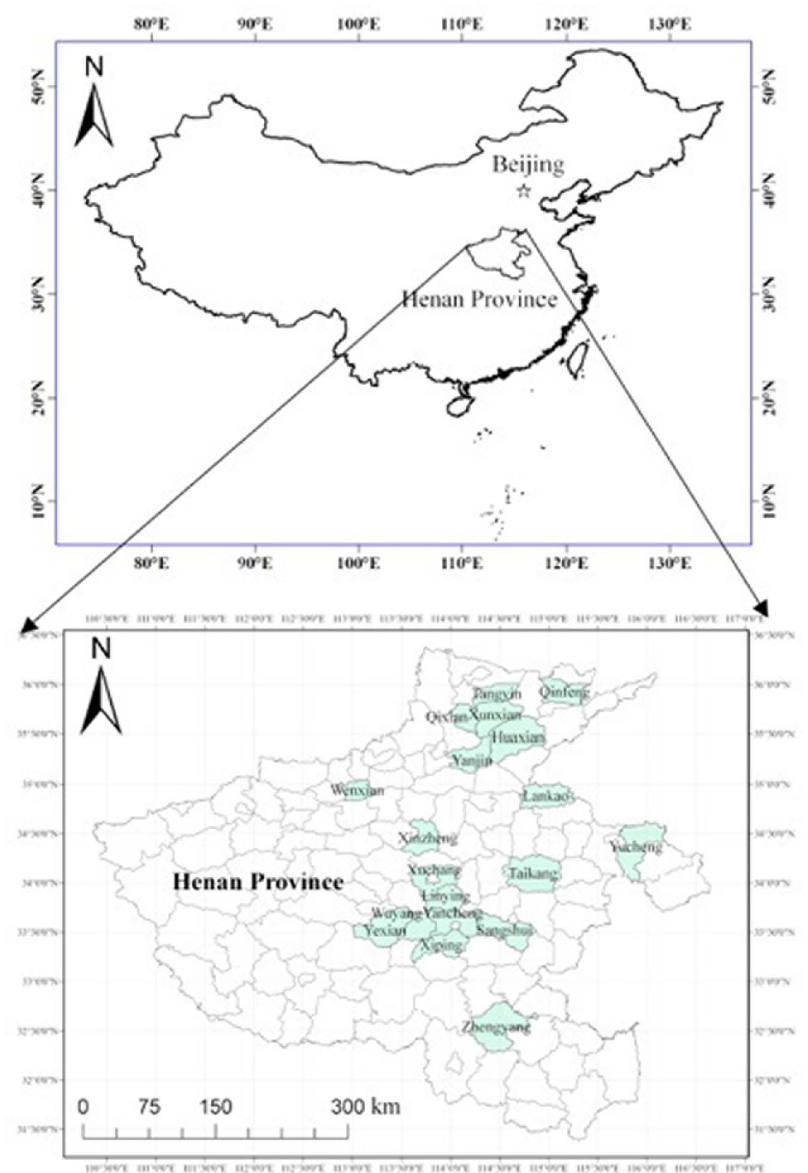
Figure 1. Map of China (top) showing location of Henan Province and counties (bottom) within Henan Province used in this study.